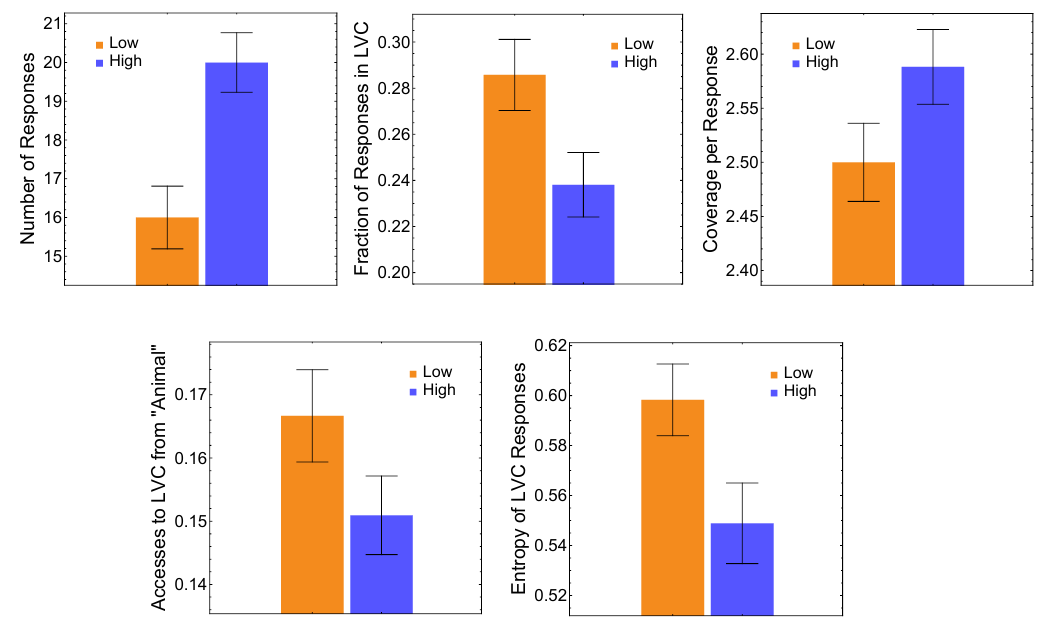
Figure 3. Medians of the lower creativity and higher creativity fluency lists in terms of: number of responses, fraction of responses in the LVC, coverage per response (i.e., number of visited nodes in the shortest path walk connecting consecutive responses), number of accesses to LVC from the category word “animal” and entropy of LVC responses. Error bars indicate the median standard error. All the above features result in differences between the lower creative and higher creative groups at p <